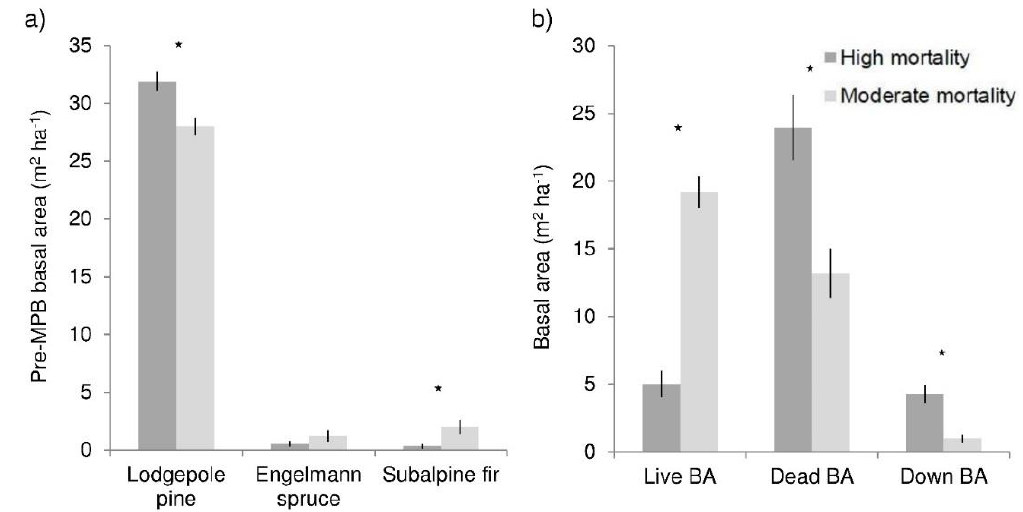
Figure 1. Overstory characteristics of high and moderate mortality areas at the Fraser Experimental Forest, Colorado: ( a ) Live basal area by species before MPB-caused mortality; ( b ) live, dead, and down basal area following MPB summed for all conifer species. Stars indicate significant differences (α = 0.05). Bars show means and lines are standard errors.